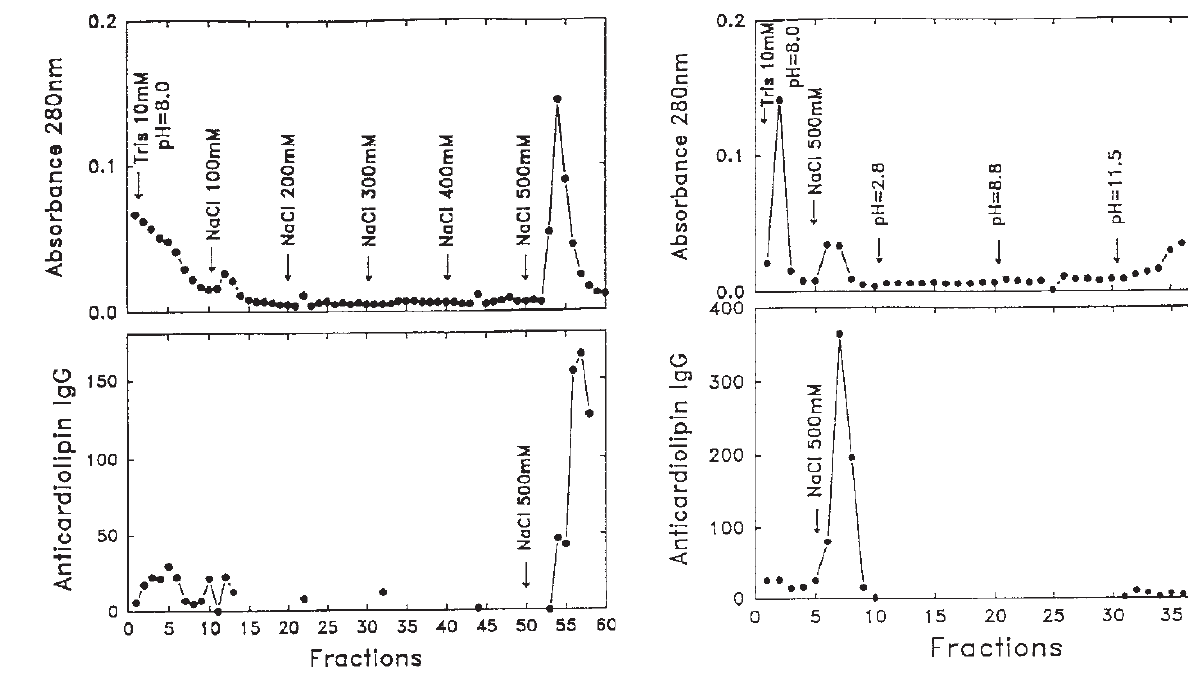
Figure 1. Results of affinity purification of anti-ATP IgG from a demented APS patient performed as described in the text. Elution buffers are indicated. Fractions collected from the column were assayed for total IgG content by spectroscopy (280 nm, upper panel) and for anticardiolipin antibodies (aCL) by ELISA (lower panel). The results indicate that most aCL could be eluted by high salt (500mM NaCl).